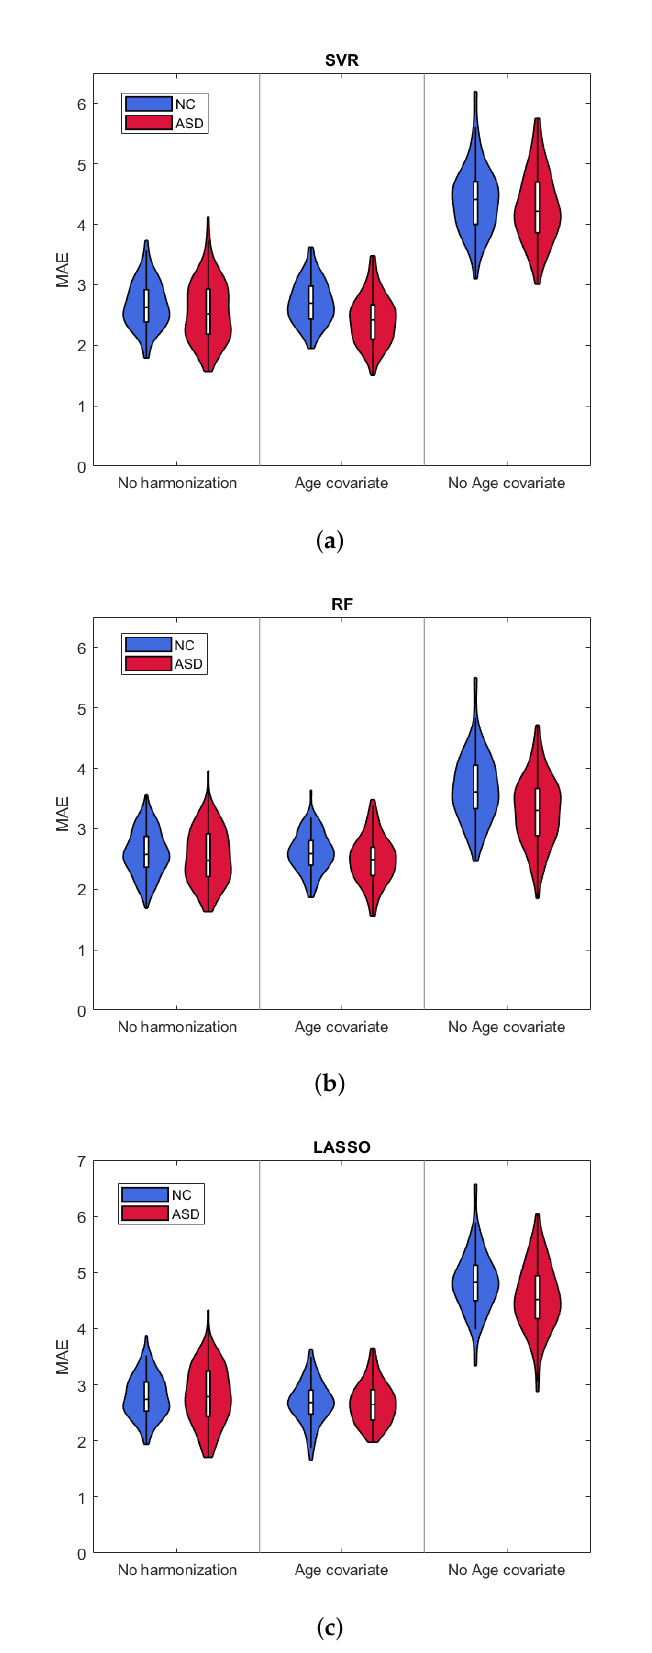
Figure 2. Violin plots of MAE resulting from ( a ) support vector regression (SVR); ( b ) Random forest (RF); and, ( c ) Lasso, for the three harmonization